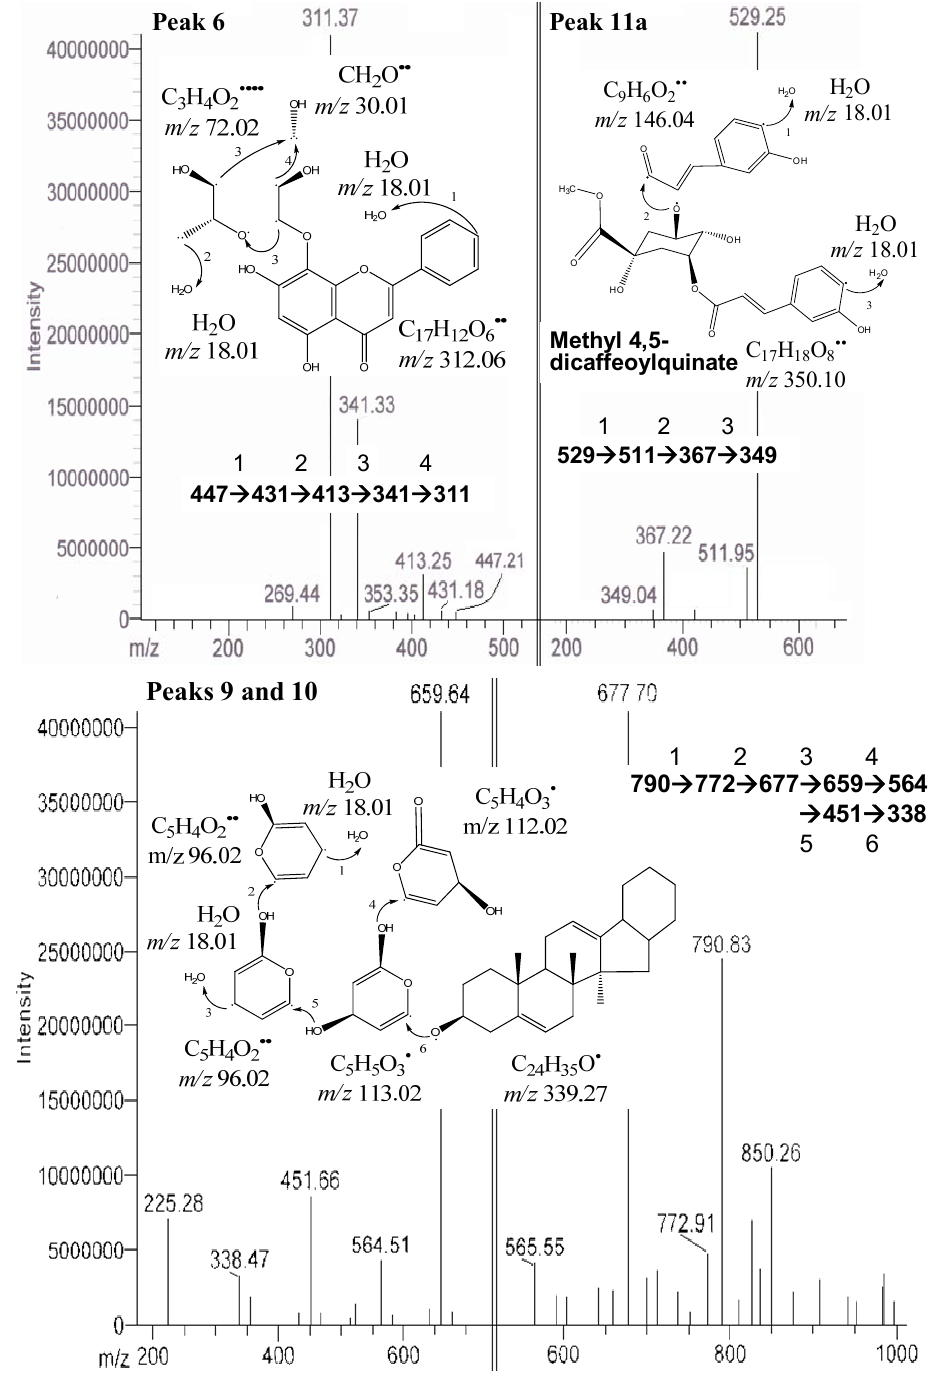
Figure 3. MS/MS of peaks 6 (apigenin 8- C -glucoside), 9 & 10 (saponin derivatives), and 11a (methyl 4,5-dicaffeoylquinate) from the defatted dabai crude extract. Peak 6 Peak